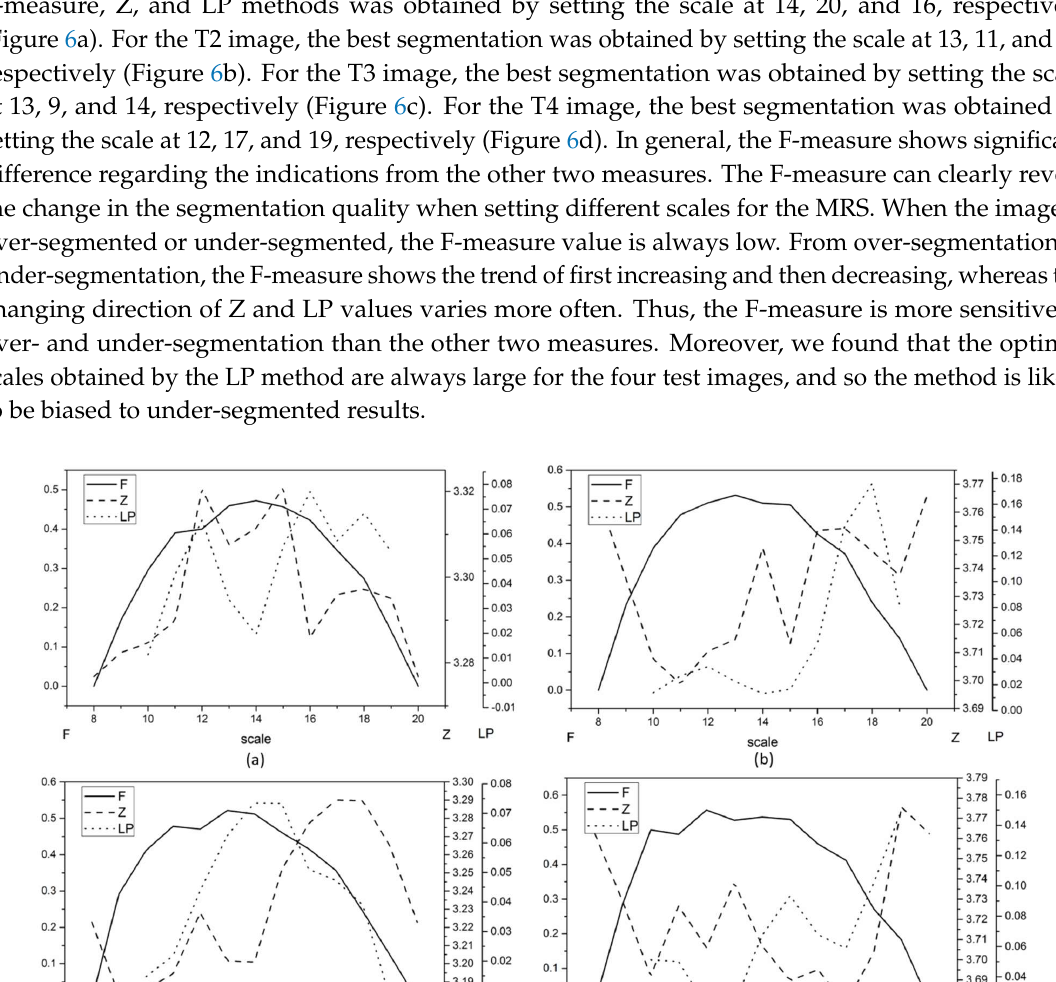
Figure 5. Subsets of segmenting four study areas: ( a–d ) are the segmentations of T1, T2, T3, and T4 produced by MRS with setting scale as 8, and ( e–h ) are the ones of T1, T2, T3, and T4 produced by MRS with setting scale as 20, respectively.